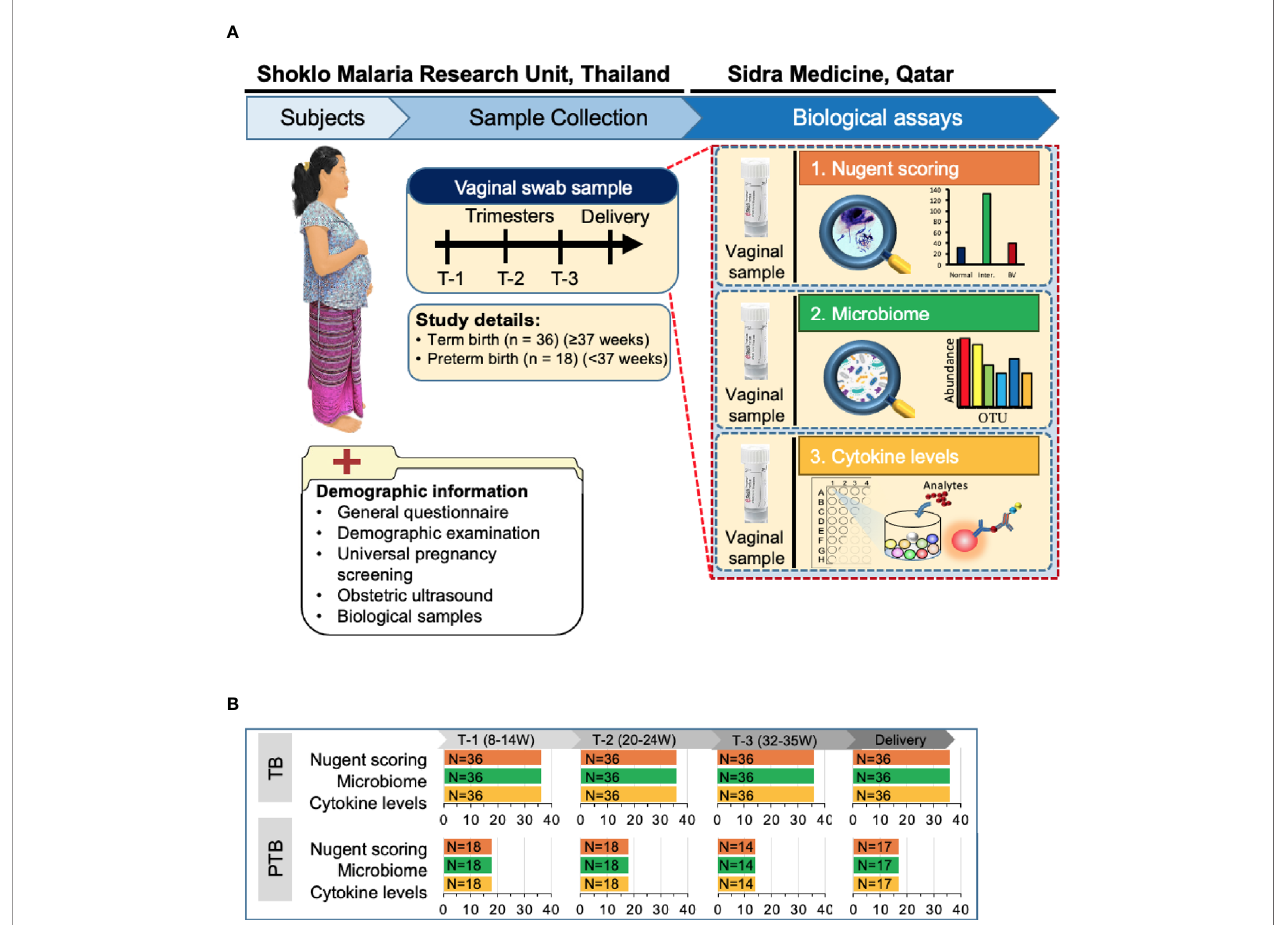
FIGURE 1 | Overview of the study design. (A) Of the 400 Karen and Burman women enrolled in Molecular Signature in Pregnancy (MSP) study, 18 pregnant women experienced PTB (pre-term birth) and 36 women who delivered at term (TB) were selected for this study. Vaginal swabs were taken from these women at Shoklo Malaria Research Unit (SMRU) health care clinics at each trimester of pregnancy: T-1 (8 – 14 weeks), T-2 (20 – 24 weeks), T-3 (32 – 35 weeks) and at delivery. Detailed demographic information was collected at the fi rst visit. Vaginal swab samples were used for Nugent scoring to determine bacterial vaginosis status, for microbiome analysis and for assessing the levels of different cytokines. BV, bacterial vaginosis; OTU, operational taxonomic unit; W, weeks of gestation. (B) Number of samples collected from women in both groups and processed for each